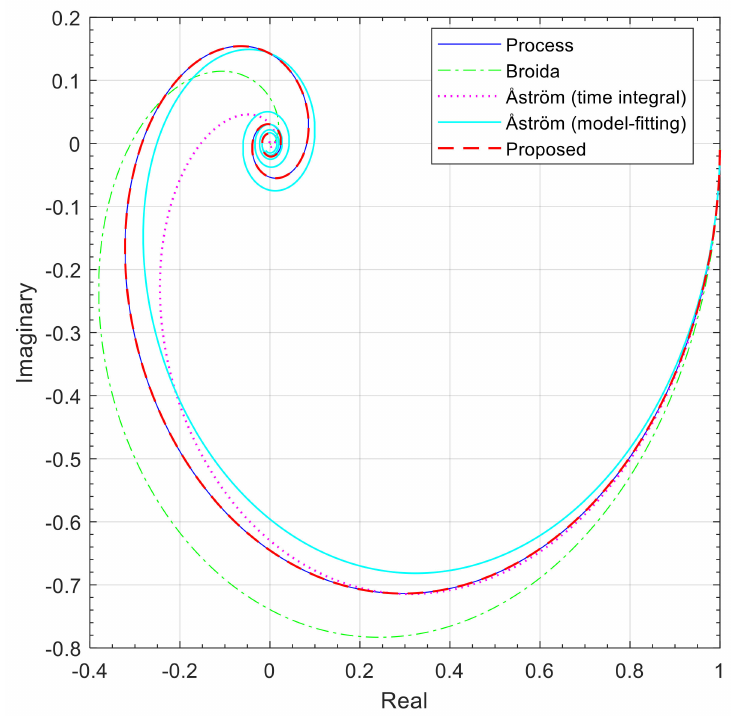
Figure 8. The Nyquist plots for process G P1